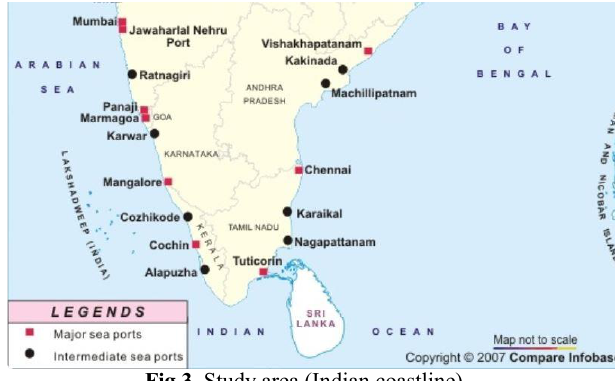
Fig 3. Study area (Indian